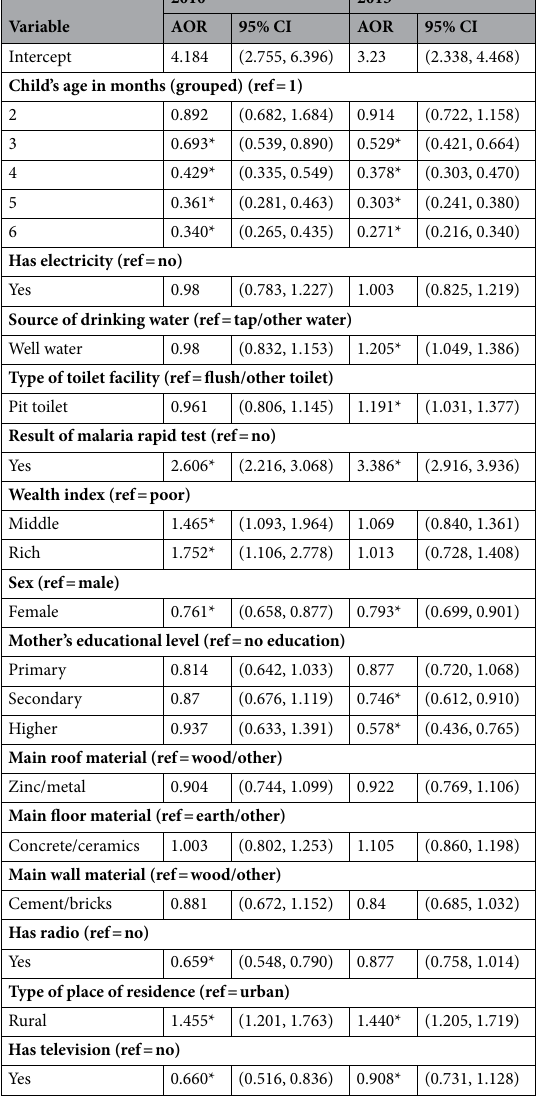
Table 5. 95% credible interval and adjusted posterior odd ratios estimates (AOR) of anaemia. *means